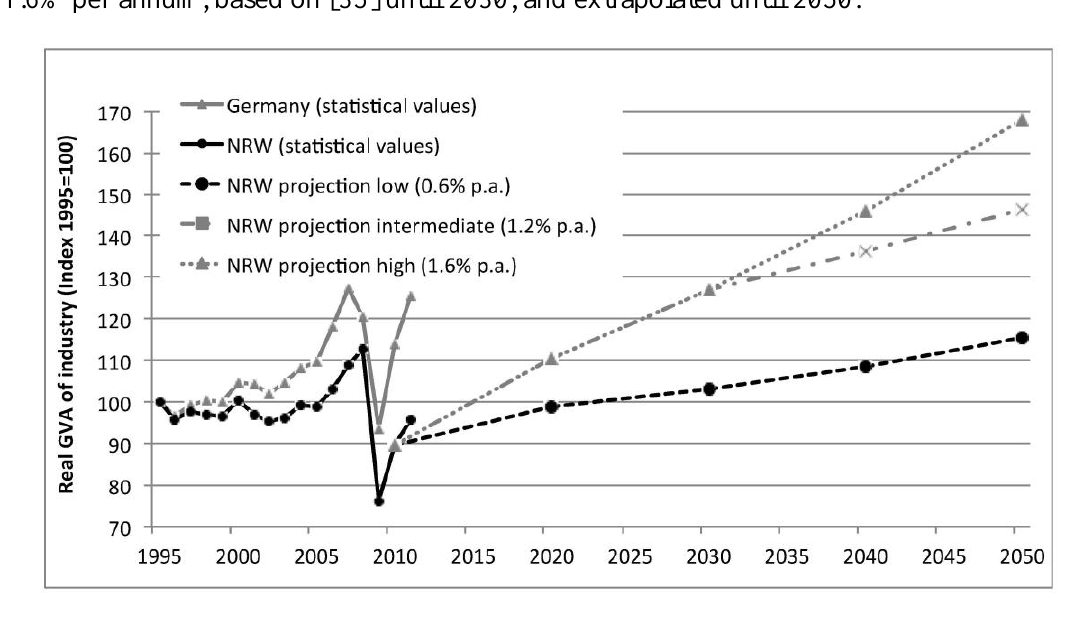
Figure 3. Three variations of potential growth pathways for industrial development in NRW. Statistical values based on Destatis (Germany) and IT.NRW databases; projections based on [34] and